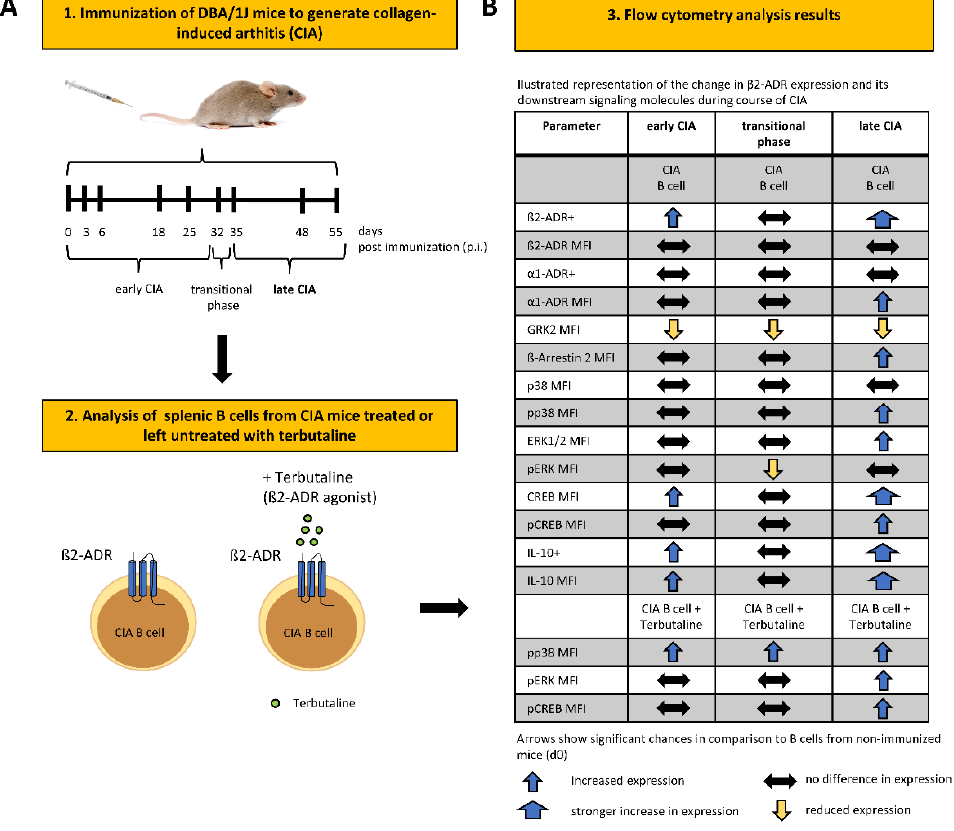
Figure 4. Alteration of β 2 ‐ ADR expression and its downstream signaling molecules in B cells are associated with severity of inflammation during collagen ‐ induced arthritis. ( A ): Illustrated repre ‐ sentation of the experimental design and ( B ) of the change in β 2 ‐ ADR expression and its down ‐ stream signaling molecules in B cells during the early, transitional and late phase of collagen ‐ in ‐ duced arthritis (CIA), treated or left untreated with the β 2 ‐ ADR agonist terbutaline. Table 1. Arthitis score during course of collagen ‐ induced arthritis.